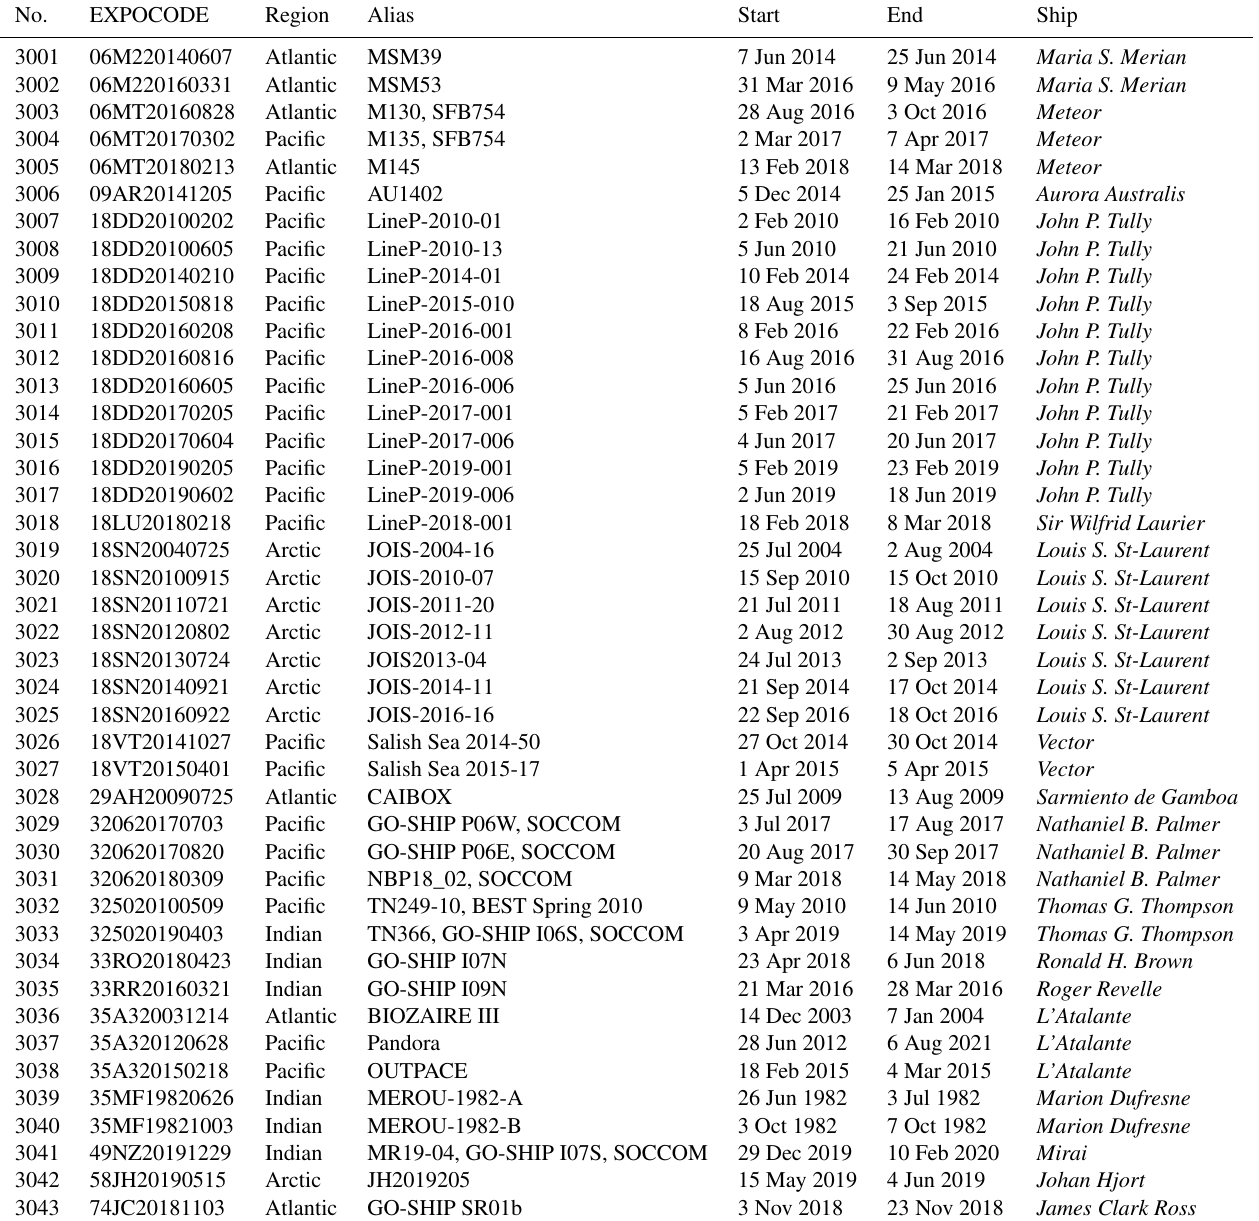
Table A1. Cruises included in GLODAPv2.2021 that did not appear in GLODAPv2.2020. Complete information on each cruise, such as variables included, and chief scientist and principal investigator names is provided in the cruise summary table at